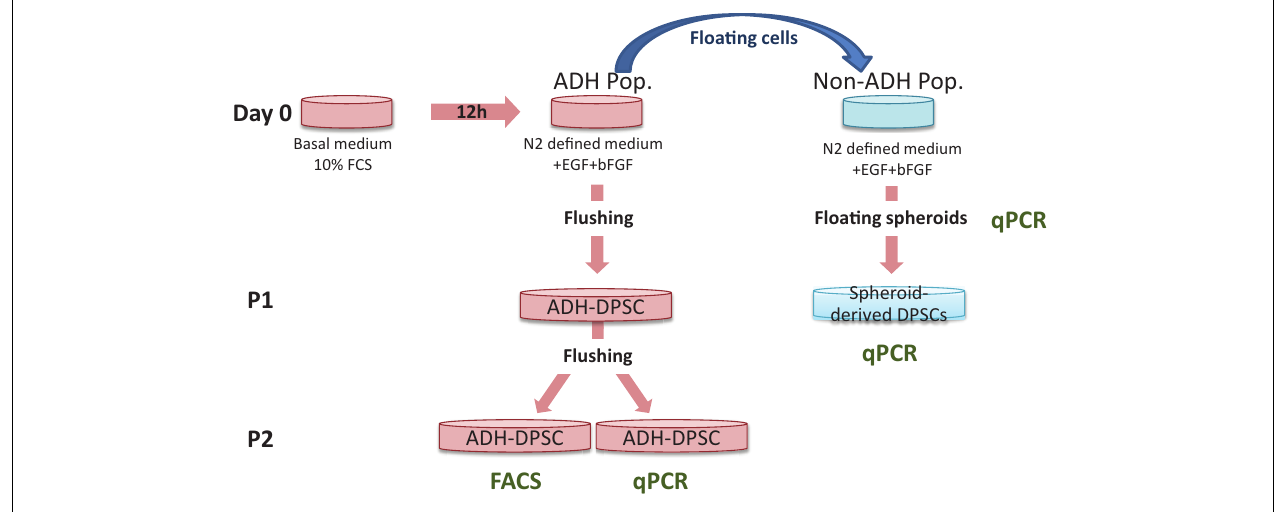
FIGURE 1 | Adherent and Non-adherent dental pulp stem cells culture conditions. Human dental pulp cells were isolated and cultured in basal medium supplemented with 10% FCS (Day 0). After 12h, medium was changed for a basal medium supplemented